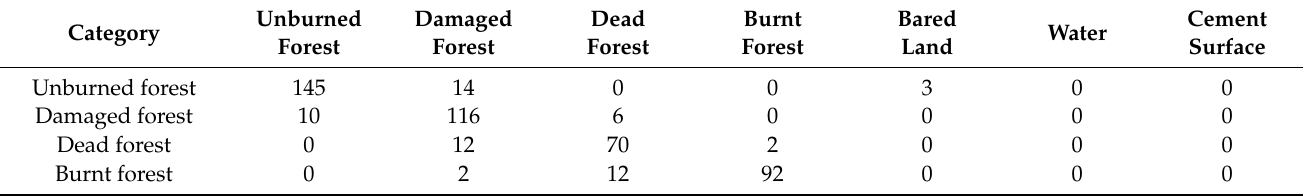
Table 4. Accuracy evaluation of the object-oriented